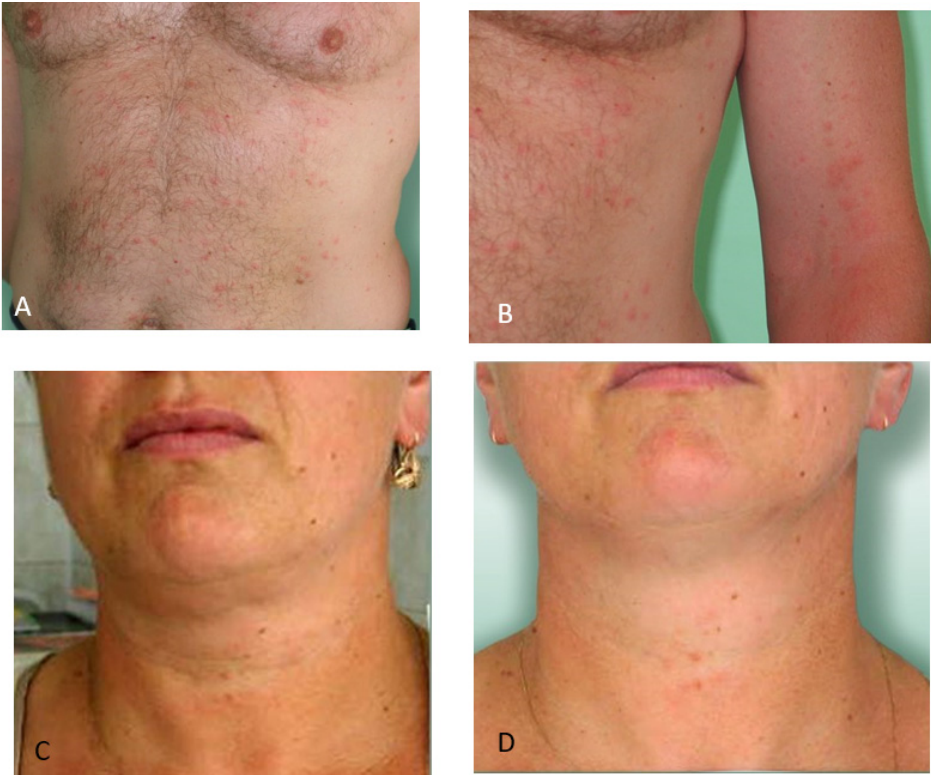
Figure 5. Skin lesions in patients without co-morbidities, attacked by blackflies repeatedly. ( A , B ) numerous papules on the abdomen, chest, and upper extremity in a male patient attacked by blackflies repeatedly (case 5); ( C , D ) Inflammatory reactions at the site of repeated blackfly bites in the lip area and papules on the neck in a female patient (case 6).